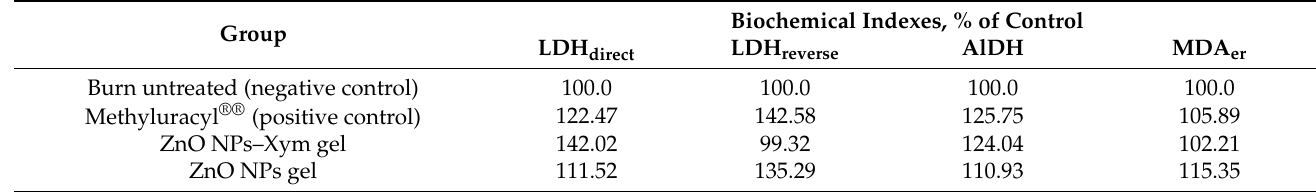
Table 7. Specific activity of AlDH and LDH in direct and reverse reactions, and the MDA level on the rat blood on the 10th day after thermal burn under the treatment by dosage forms, in % of control ( n = 3, p < 0.05).